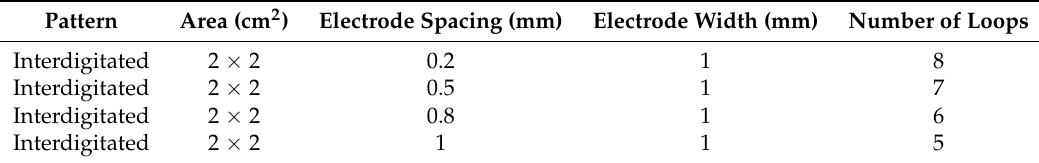
Table 5. Parameters of FEF (fringing electric field) sensors in Figure 14.